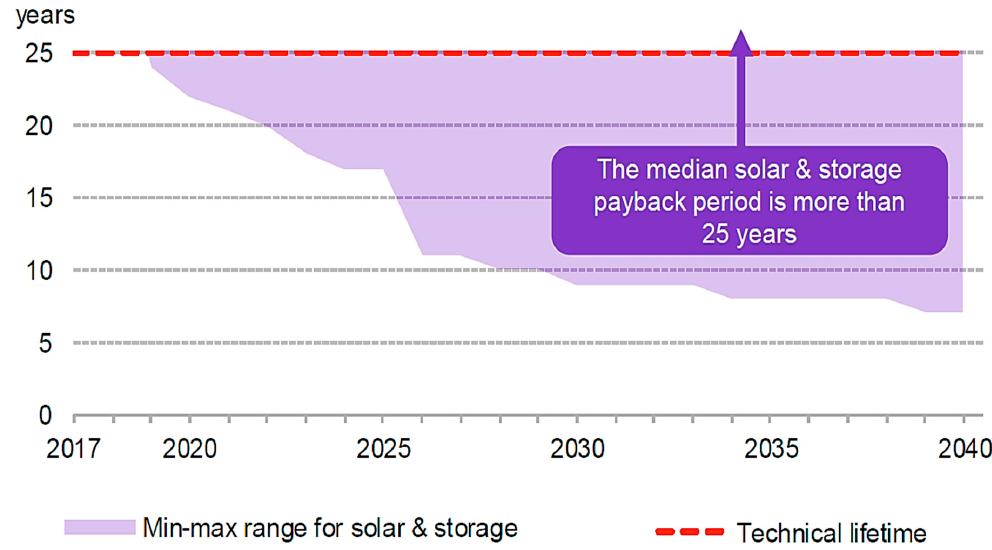
Figure 3. Payback period for residential small-scale PV systems with storage in Europe [40].